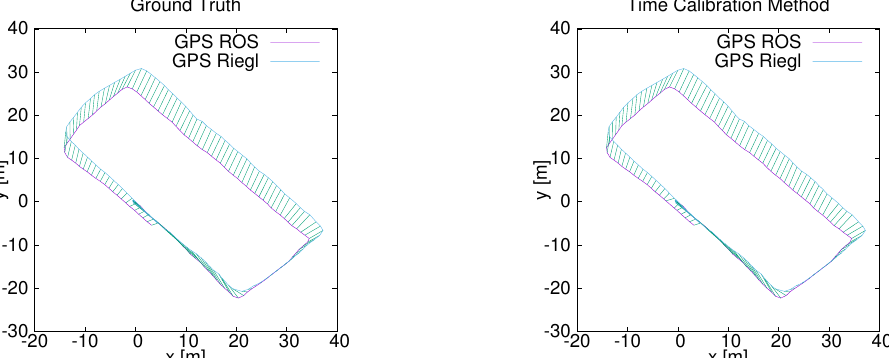
Figure 15. Data synchronization results. ( Left ): Synchronizing data by ground truth. ( Right ): Synchronizing data by the proposed time-calibration method. The trajectory is from the ParkingG data set.